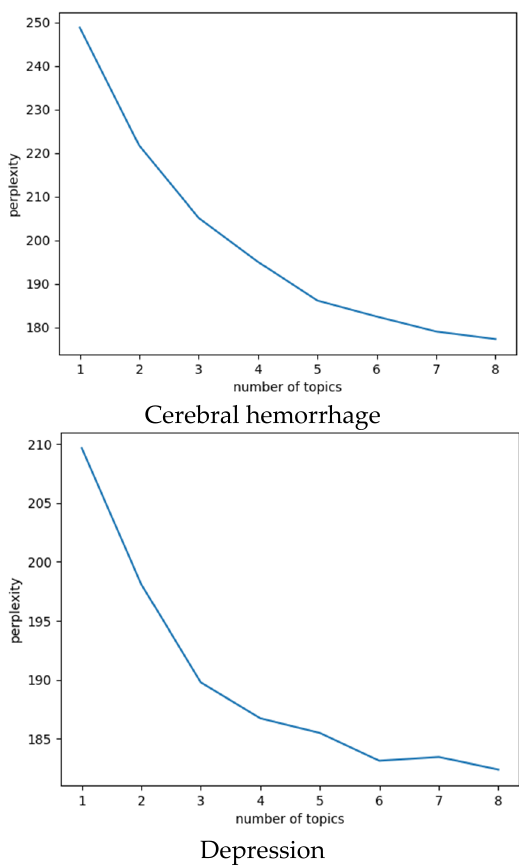
Figure 2. Perplexity Curve.